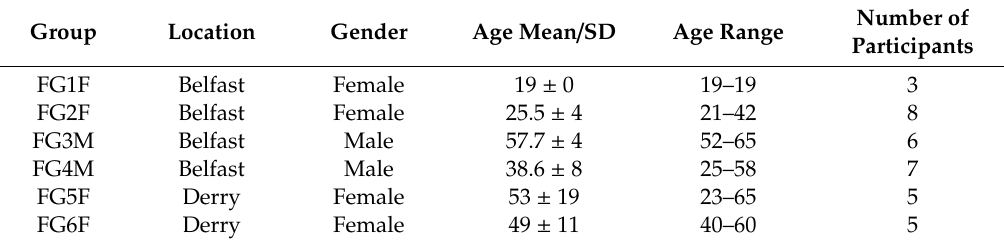
Table 1. Focus Group Demographics.